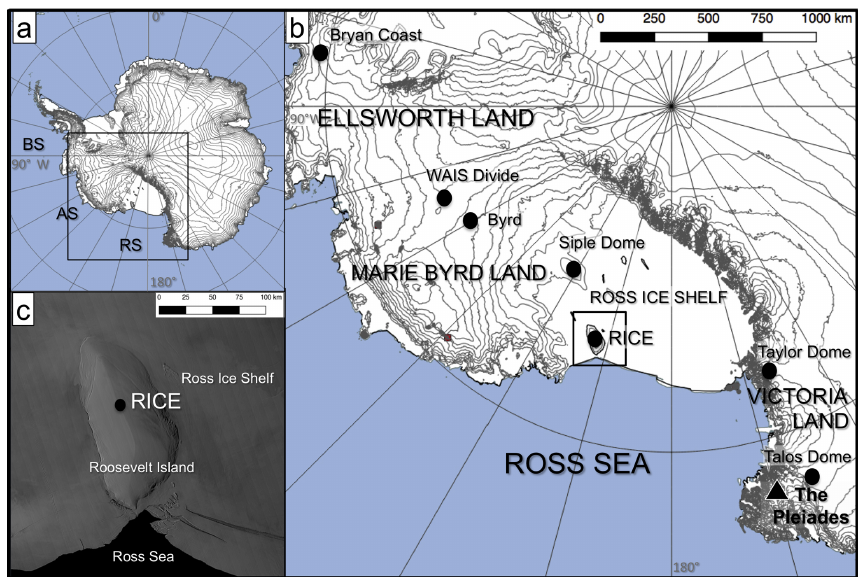
Figure 1. (a, b) Roosevelt Island is located in the eastern sector of the Ross Ice Shelf embayment. Locations discussed in the text are represented by circles (ice cores) and a triangle (volcano). RS: Ross Sea; AS: Amundsen Sea; BS: Bellingshausen Sea. (c) MODIS image of Roosevelt Island (Haran et al., 2013), protruding as an ice dome from the surrounding Ross Ice Shelf. The RICE ice core was drilled on the ice divide of Roosevelt